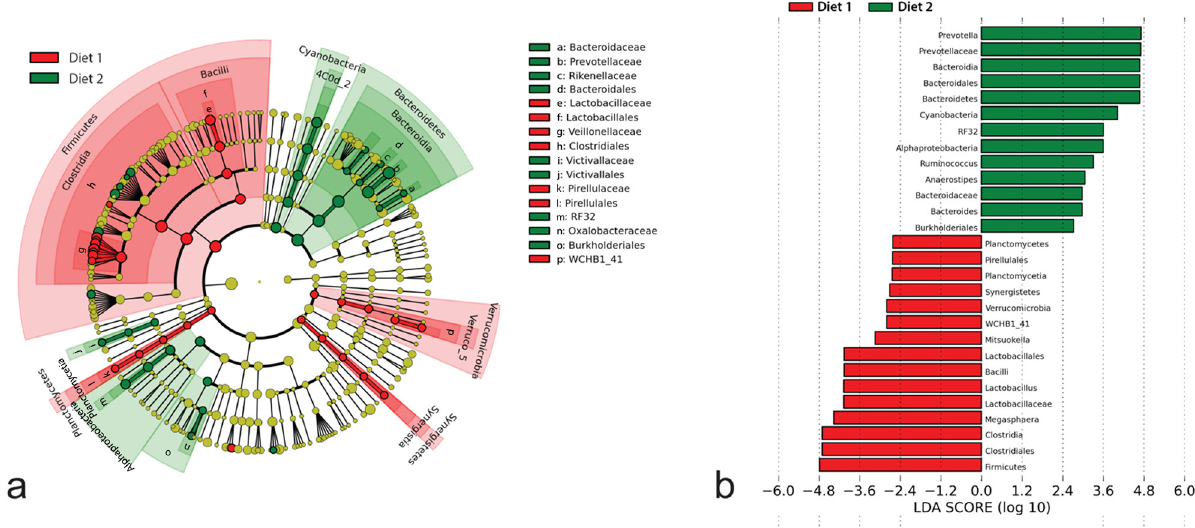
Fig 2. Linear discriminant analysis reveals predicted biological effect sizes of differential taxa in microbiota samples from pigs fed different amounts of insoluble fiber. (a) Cladogram revealing statistically and biologically consistent differences in detected taxa between colonic content samples from pigs fed no DDGS (Diet 1) or 30% DDGS (Diet 2) according to LEfSe. Differences are represented by the color of the diet group in which specific taxa were most abundant (Red = Diet 1, Green = Diet 2) and the diameter of each circle is proportional to the relative abundance. At the phylum level, Firmicutes were more abundant in samples from pigs fed Diet 1 whereas Bacteroidetes were more abundant in samples from pigs fed Diet 2. (b) Histogram of linear discriminant analysis (LDA) scores computed by LEfSe revealing differentially abundant taxa in the microbiota of the two diet groups including overabundance of Prevotella spp. and depletion of Lactobacillus spp. in pigs fed 30% DDGS (Diet 2).